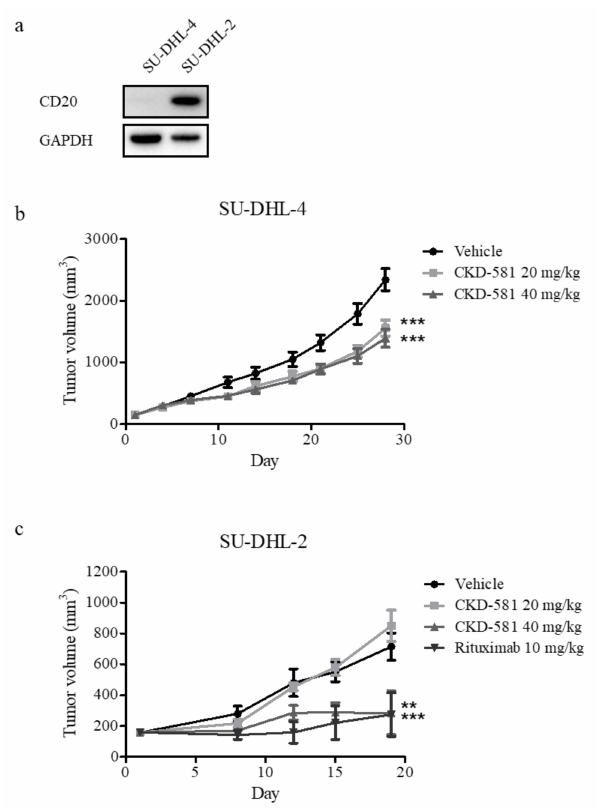
Figure 5. CKD-581 suppressed DH-DLBCL tumor growth in the mouse xenograft models. ( a ) CD20 expression in DH-DLBCL cells. CD20 expression levels were compared in SU-DHL-4 and SU-DHL-2 cells by immunoblotting. ( b , c ) Xenograft tumor growth assays. NOD.CB17 SCID mice were implanted with ( b ) SU-DHL-4 (1 × 10 6 cells / mouse) or ( c ) SU-DHL-2 (1 × 10 6 cells / mouse) cells. When tumors grew to about 150 mm 3 , the mice were intraperitoneally injected with vehicle, CKD-581 (20 and 40 mg / kg), or rituximab (10 mg / kg) according to the treatment schedule. Data represent mean ± SEM (( n = 10, SU-DHL-4; n = 6, SU-DHL-2) significant vs. vehicle group; * p < 0.05, ** p < 0.01, *** p <